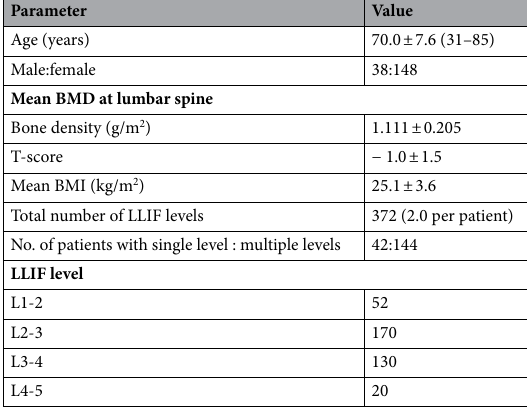
Table 1. Patient demographic and surgical data. BMD bone mineral density, BMI body mass index, LLIF lateral lumbar interbody fusion.